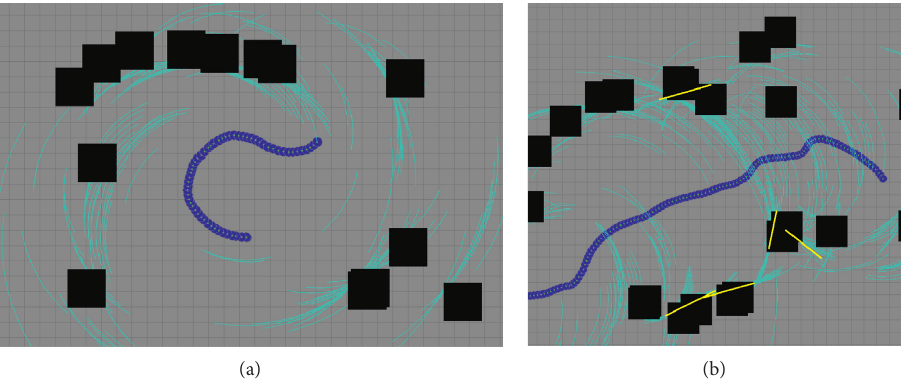
Figure 4: (a) SLAM experiment 1; (b) SLAM experiment 2.